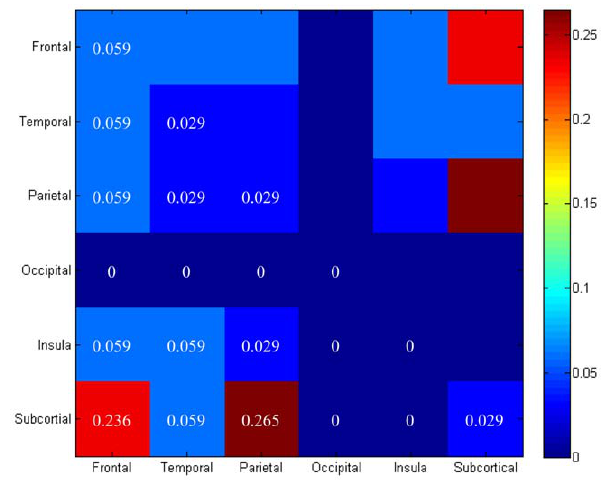
Figure 2. Proportion of connections affected in internet addiction linking distinct pairs of broad cerebral divisions. The number of links involving each pair of divisions is normalized by total number of pair-wise links.Note that the hippocampus, globus pallidus, and putamen were assigned to the subcortical category, and the anterior cingulate gyrus was assigned to the frontal category. The amygdala and caudate nucleus were not included in the disrupted network and thus there was no need to assign these regions to a lobe. The putamen, bilaterally, was the most extensively involved subcortical region, showing decreased connections with all three major cerebral lobes involved.